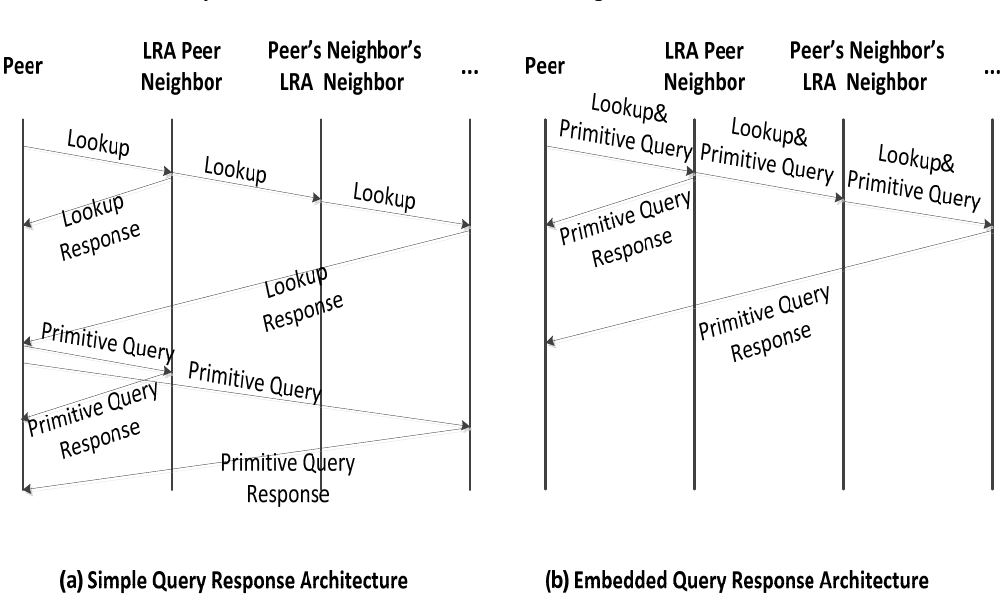
Figure 9. Time-space diagram showing the lookup and query-response processes for the ( a ) simple and the ( b ) embedded communication architectures.